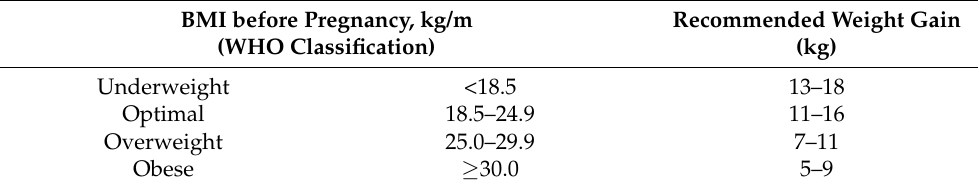
Table 1. Recommendations for weight gain during pregnancy according to BMI classification before pregnancy